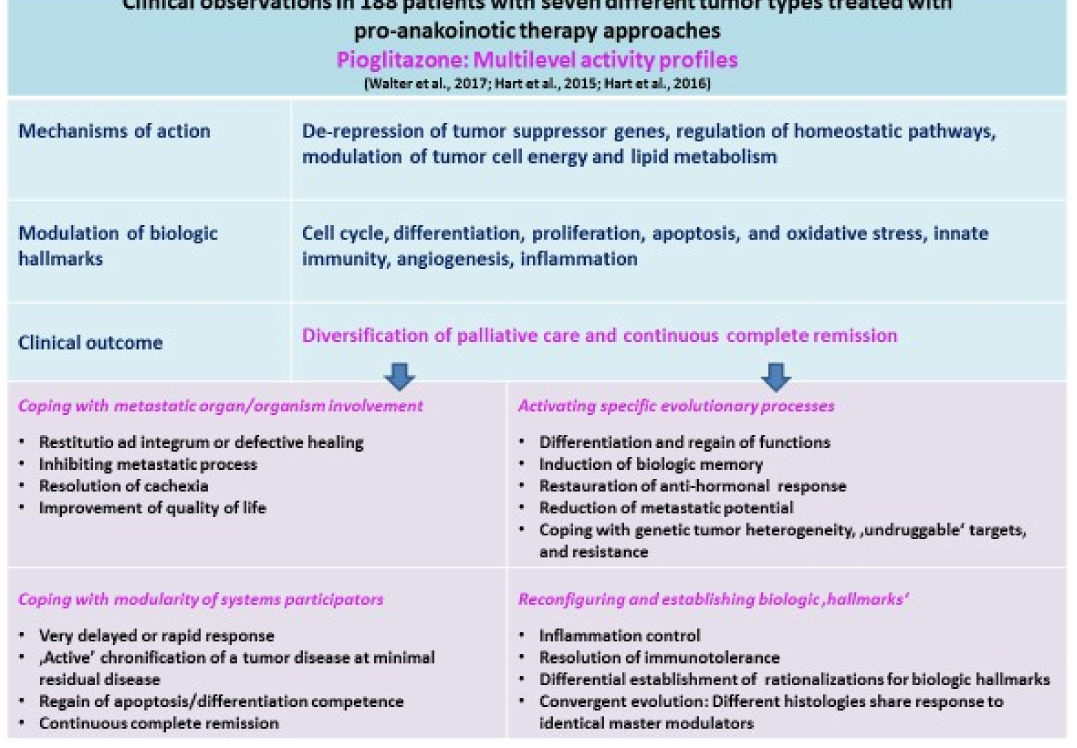
Figure 1. Pioglitazone in tumor therapy regulates the communicative interface of transcriptional modulation, lipid and carbohydrate metabolism, particularly in combination with additional master modulators. Thus, tumor-promoting pathways can be functionally attenuated without direct blocking tumor-promoting pathways or by shutting off tumor-associated cellular compartments. Clinical equivalents are diversification of palliative care, even continuous complete